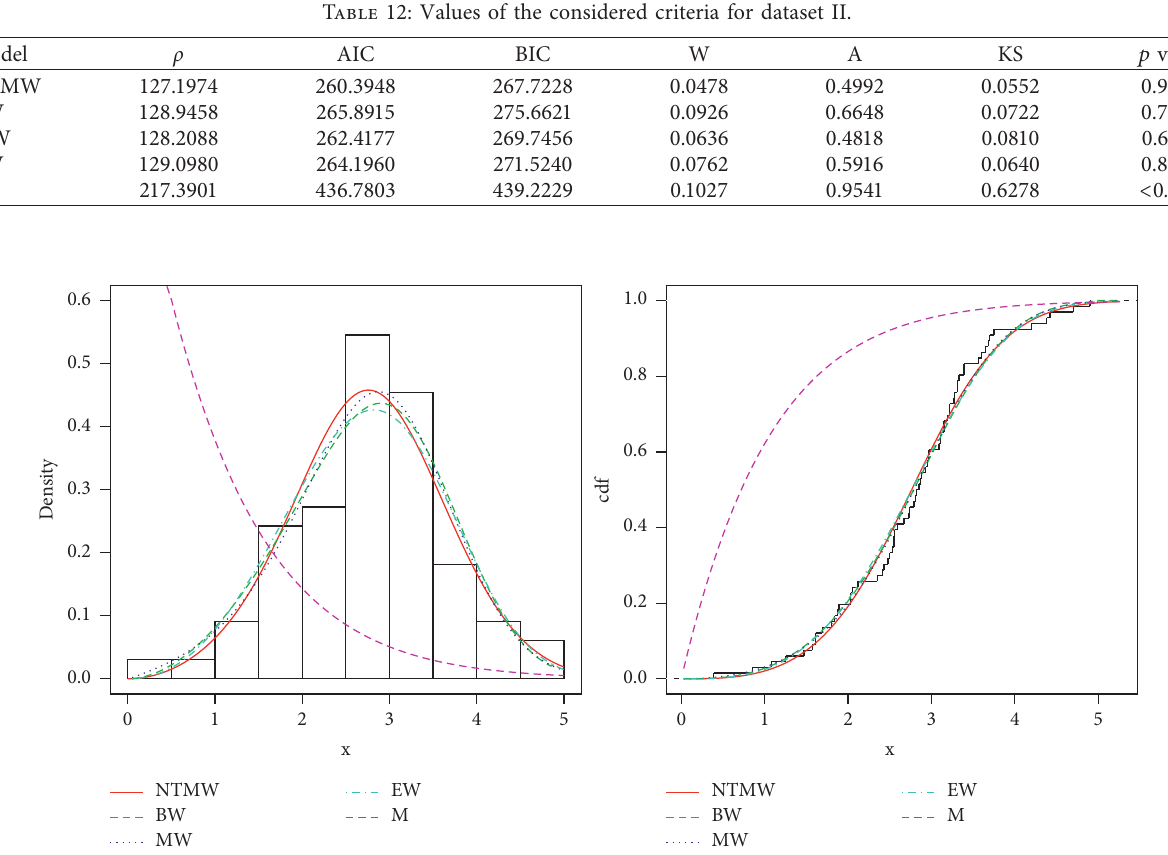
Figure 2: Estimated pdfs (a) and estimated cdfs (b) for the considered models for dataset I.